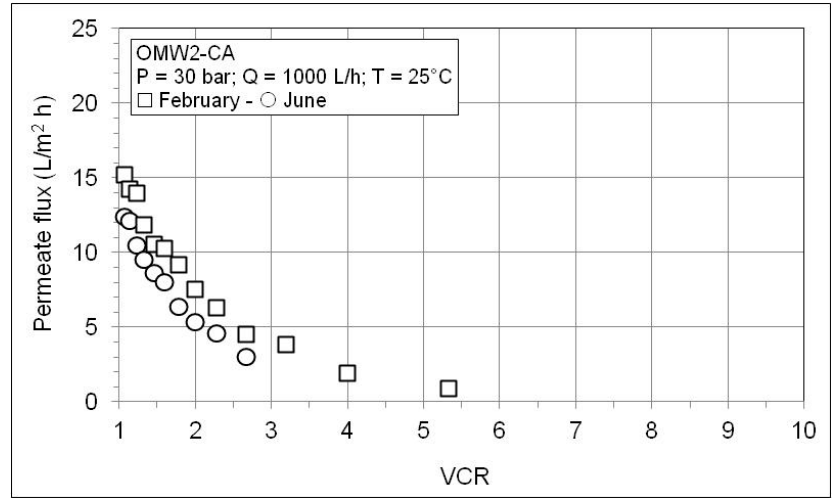
Figure 10. Effect of storage of OMW2-CA on the permeate flux as a function of VCR during MF test.